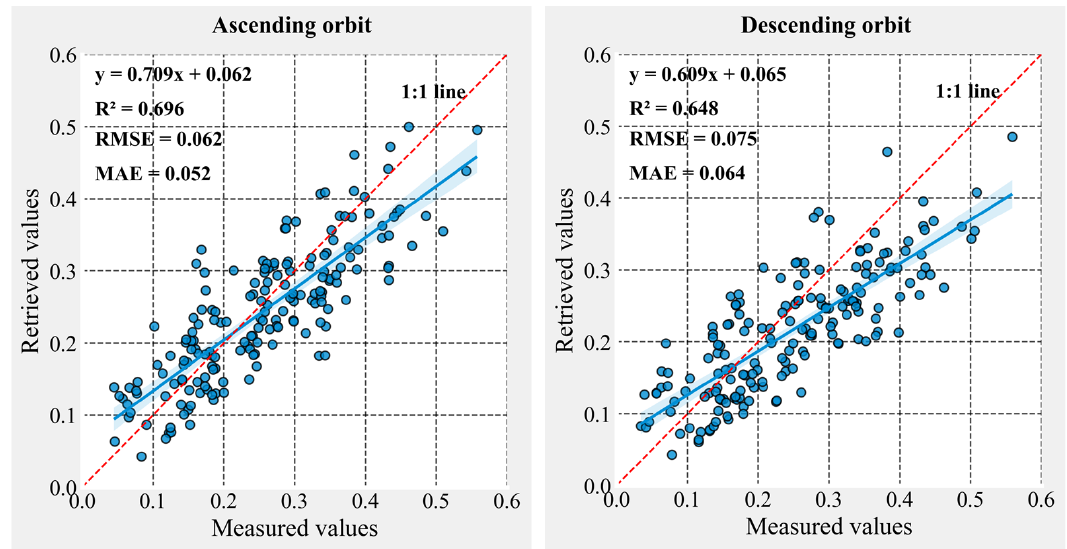
Figure 13. Soil moisture with RF for descending orbit of Tianjun network for 2020.